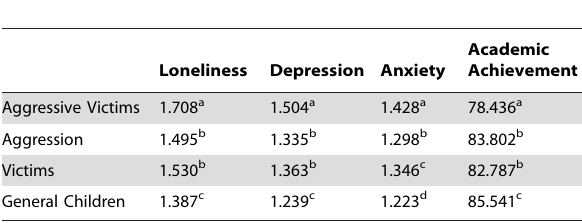
Table 2. Difference Tests of Each Latent Category on Each